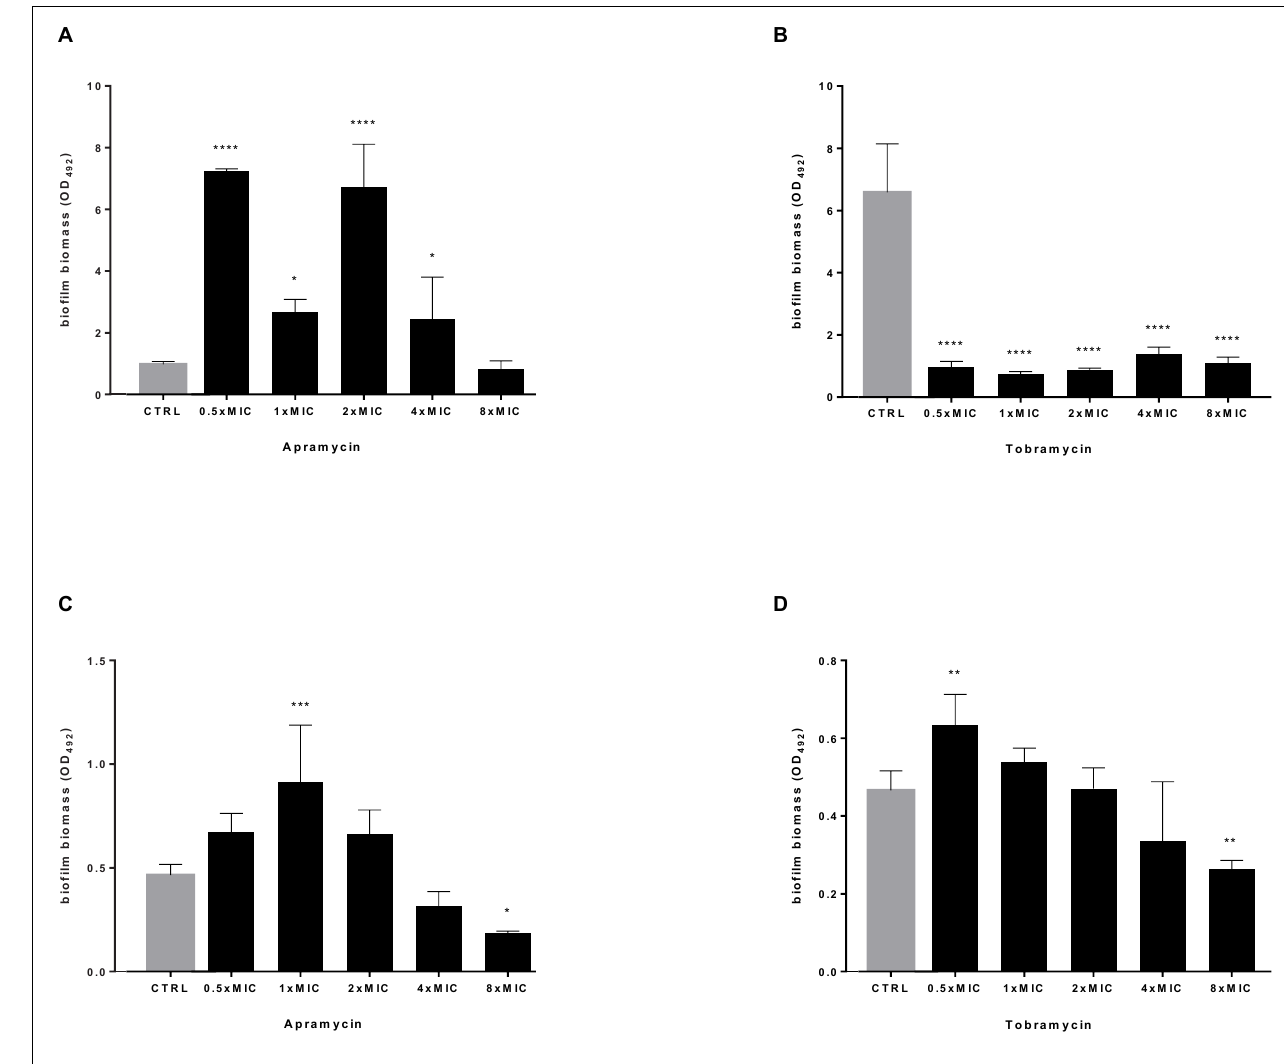
FIGURE 4 | Dispersal activity against preformed P. aeruginosa biofilm. The efficacy of apramycin and tobramycin to disperse 24 h-mature biofilm by P. aeruginosa Pa7 (A,B) and PaPh32 (C,D) was assessed using crystal violet assay. Each drug was tested at fractions and multiples of MIC value (apramycin: 64 and 32 mg/L; tobramycin: 2 and 64 mg/L, respectively, for Pa7 and PaPh32). Results are expressed as mean + SD of the residual biofilm biomass (OD 492 ) after 24 h-exposure. Control samples (CTRL) were not exposed to drug. Statistical significance at ordinary one-way ANOVA followed by Holm-Sidak’s multiple comparisons